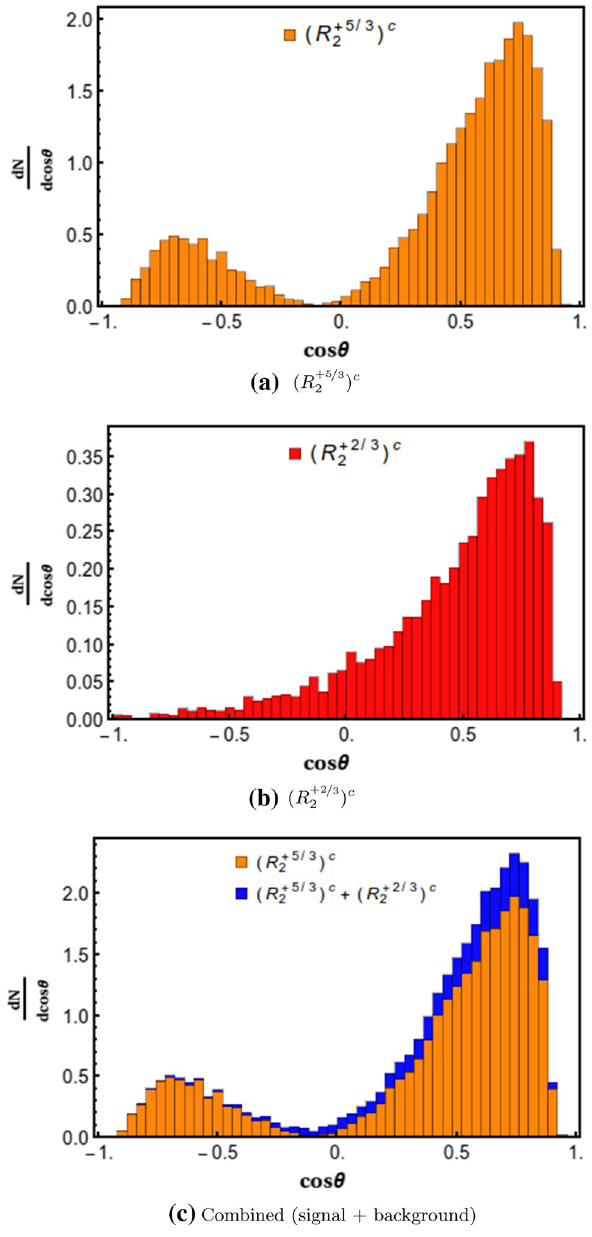
Fig. 6 Angular distribution with respect to the angle (θ) made by the photon with the incoming electron beam, at = 100 fb − 1 in the CM frame. The sub-figure (a) shows the angular L int distribution for the associate production of ( R + 5 figure(b)displaysthesamefor ( R + 2 the angular distributions of the signal and background together in the rest frame of interaction